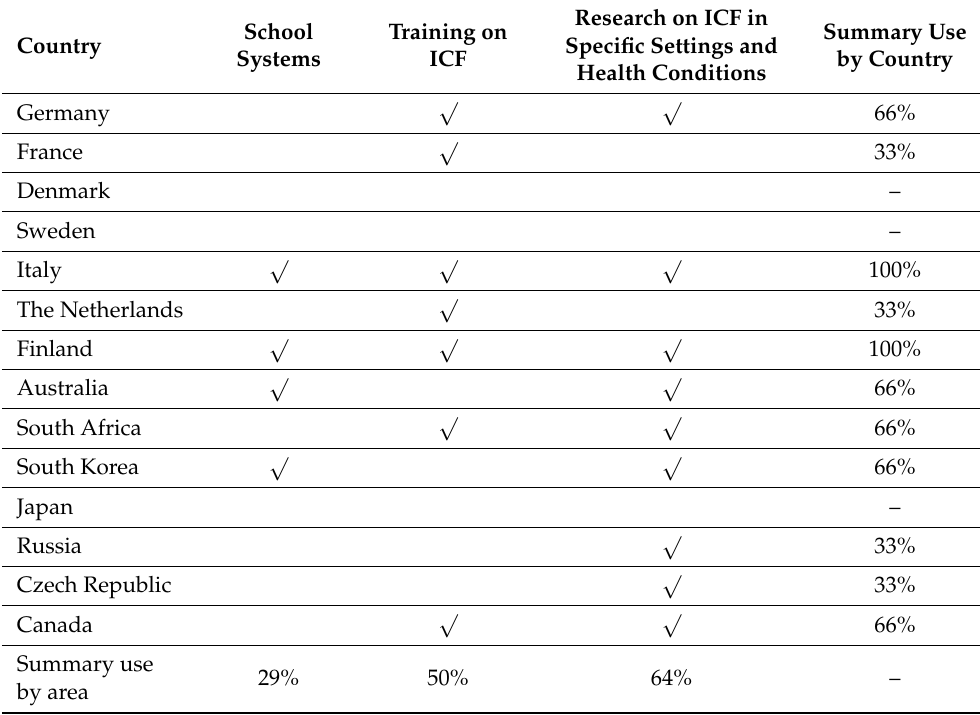
Table 5. ICF implementation in educational area, training on ICF and ICF use in